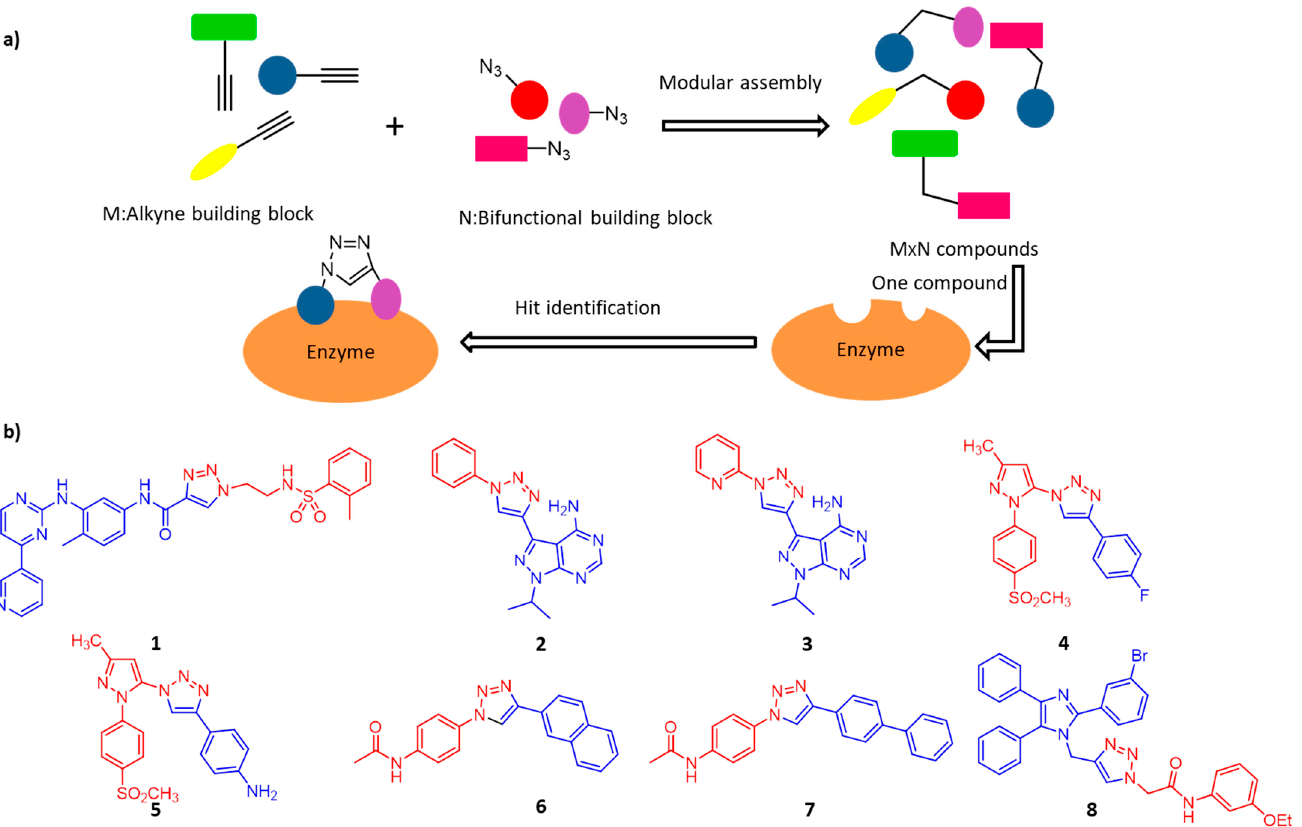
Figure 5. ( a ) Illustration of in situ click chemistry contributes to rapid assembly of potential bidentate inhibitors (M × N compounds) from N number of alkynes and M number of azides. ( b ) Potent and selective click-inhibitors of 1: Abl kinase, 2 and 3: PfPK7, 4 and 5: COX-2, 6 and 7: OGT, and 8: α -Glucosidase.